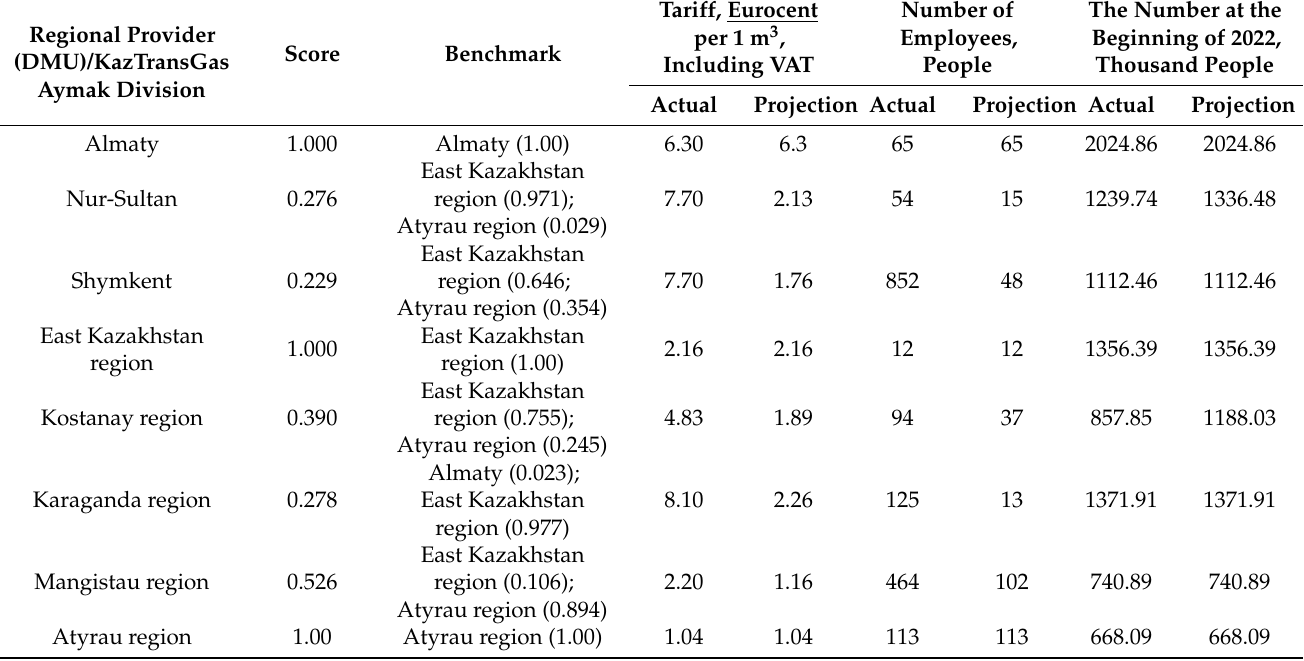
Table 9. Envelopment Model Input-oriented results for 2022’s gas supply.